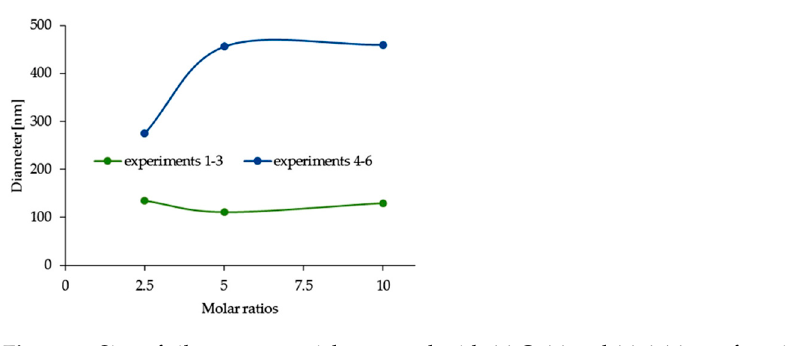
Figure 7. Size of silver nanoparticles capped with 16-O-16 and 16-6-16 as a function of nAg/nGemini molar ratio.